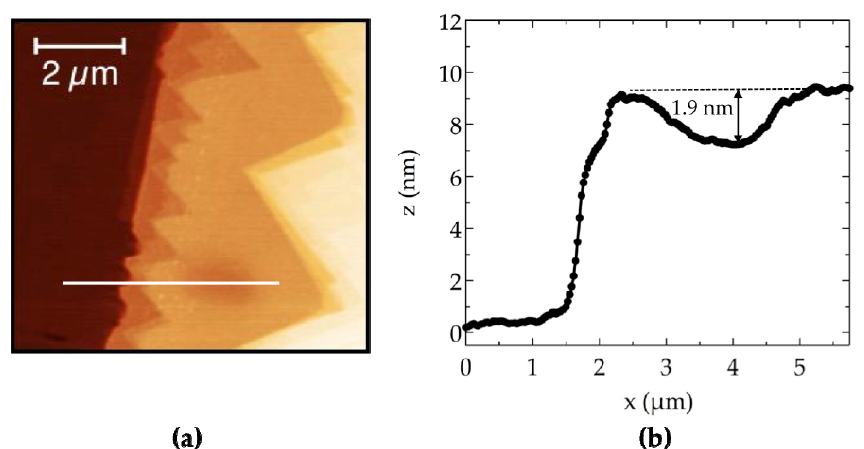
Figure E1. ( a ) AFM tapping image and ( b ) height profile of a ZrS 2 flake after Raman measurement. During the measurement the flake has been exposed to a laser spot (power density of 5.25 mW/ μ m 2 ) for some minutes, causing a hole of about 1.9 nm on the flake surface.